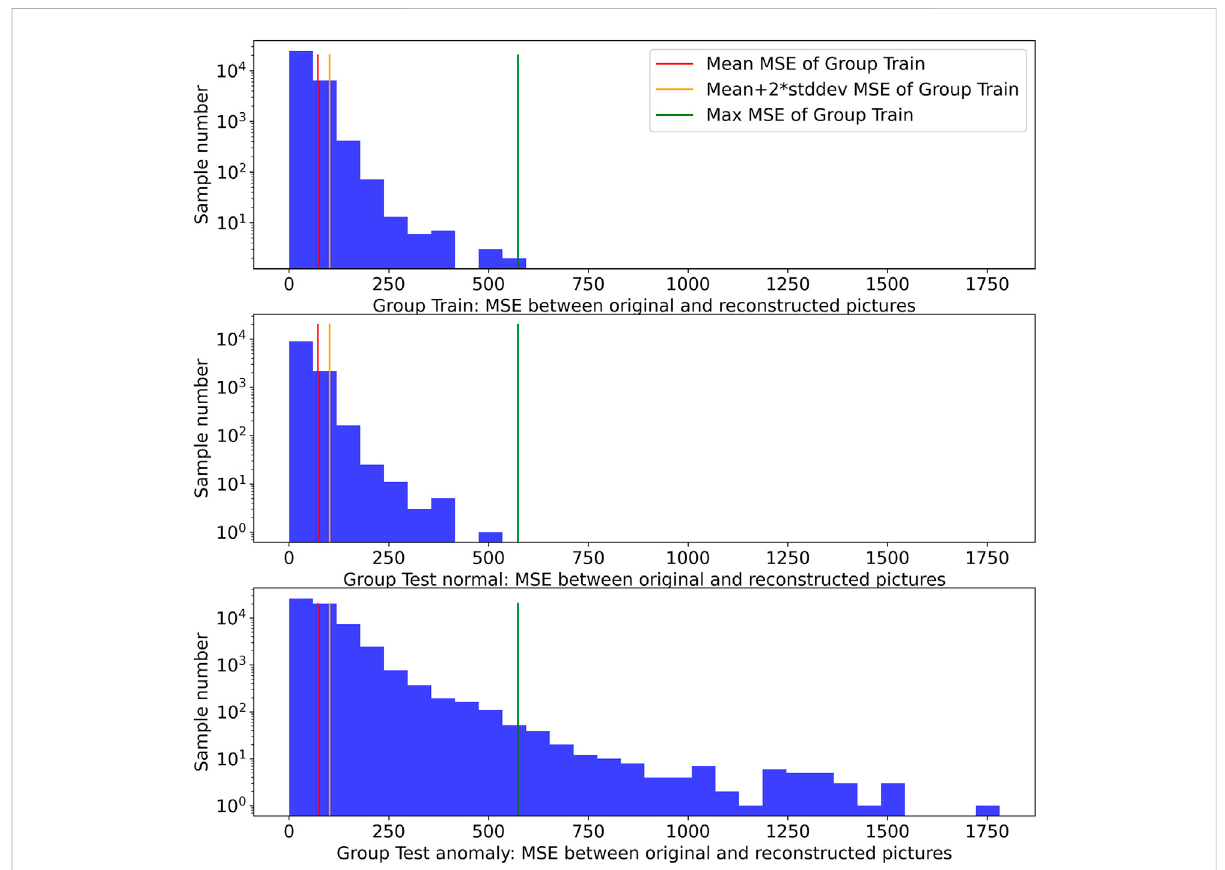
FIGURE 4 Histograms of MSEs of the original and reconstructed pictures derived by the auto-encoder network. From the top to the bottom, there is a histogram of MSEs calculated using group train, group test normal, and group test anomaly. The red, orange, and green vertical lines refer to the mean value, mean + 2 × standard deviation (std: dev), and maximum of MSEs using group train,